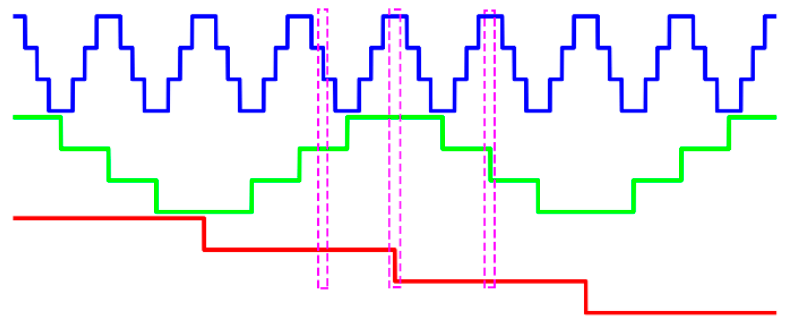
Figure 2. The n -ary gray-level ( n GL) method.